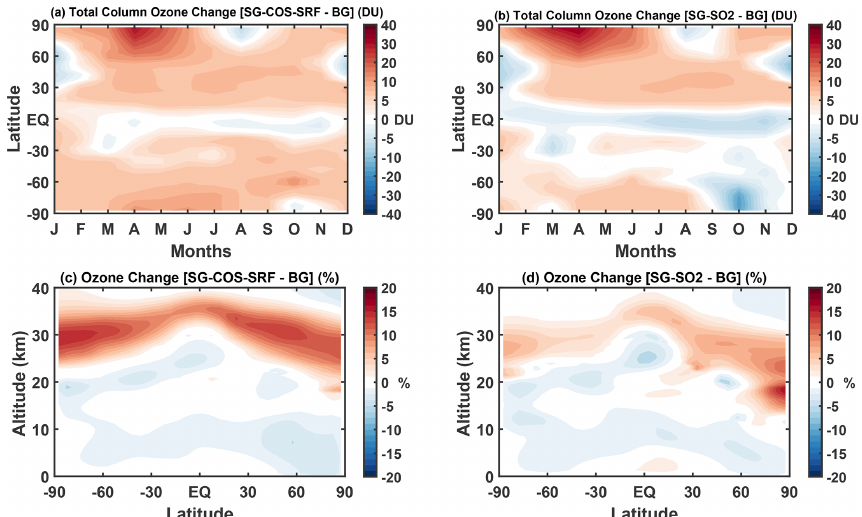
Figure 7. (a, b) Monthly mean zonal values of the SG ozone total column changes (DU) with respect to the BG case for SG-COS-SRF and SG-SO2, respectively. (c, d) Ozone mixing ratio percent changes with respect to the BG case. All quantities are annually averaged over the years